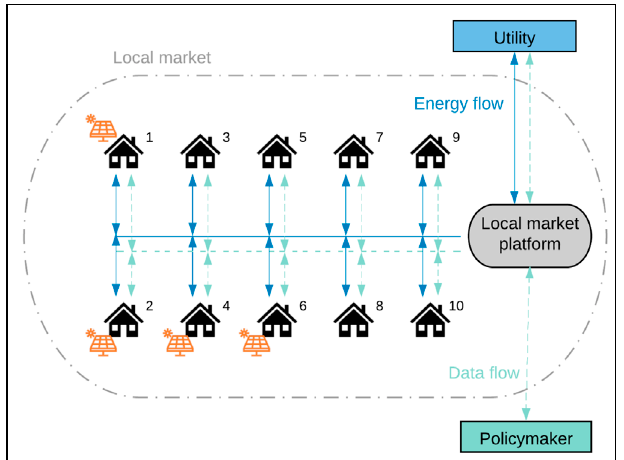
FIGURE 3 | Illustration of the analyzed local market.